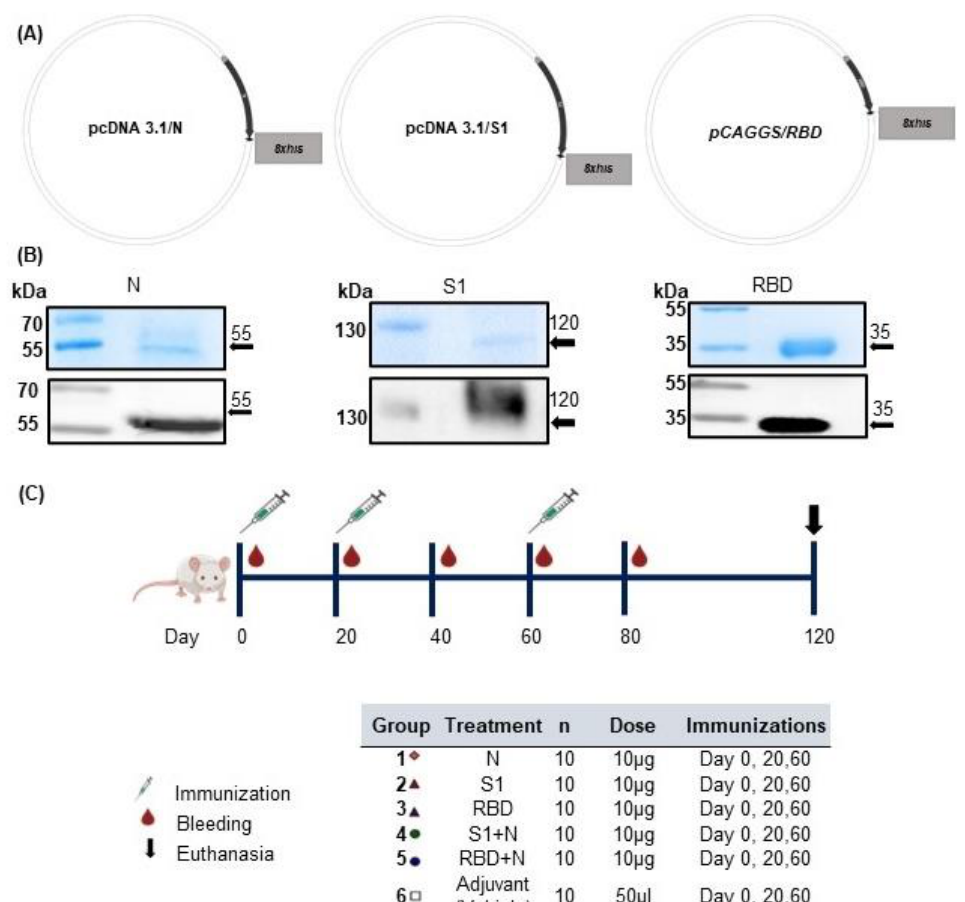
Figure 1. Design and expression of recombinant proteins and immunization scheme. ( A ) Schematic diagrams of plasmids, namely, pcDNA3.1/N, pcDNA3.1/S1, and pCAGGS/RBD. ( B ) SDS-PAGE and WB of the purified recombinant proteins N, S1, and RBD of SARS-CoV-2. ( C ) Scheme of immunization with recombinant proteins.